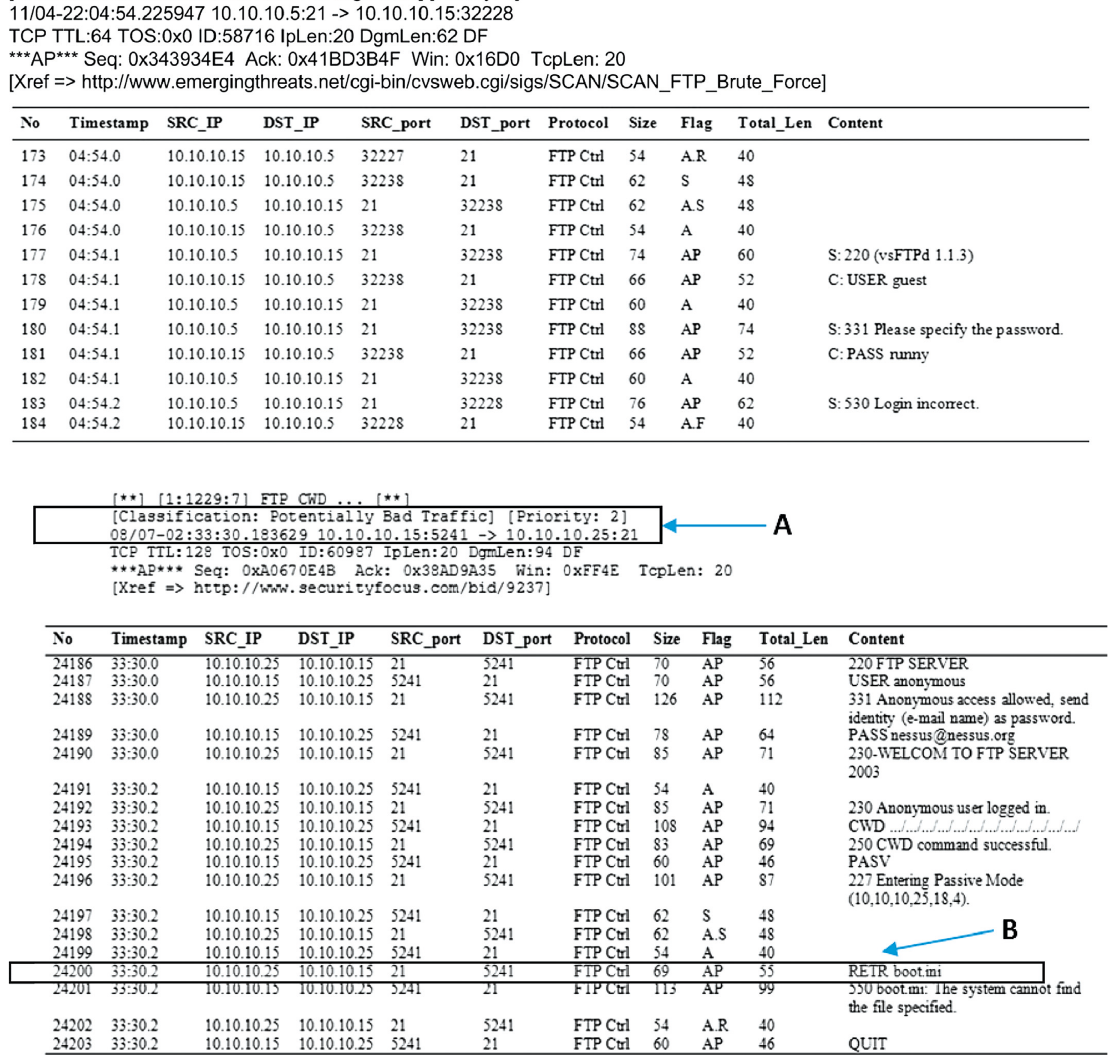
Figure 13: Confirmation of alert on attack by the detection algorithm (A) and by Snort